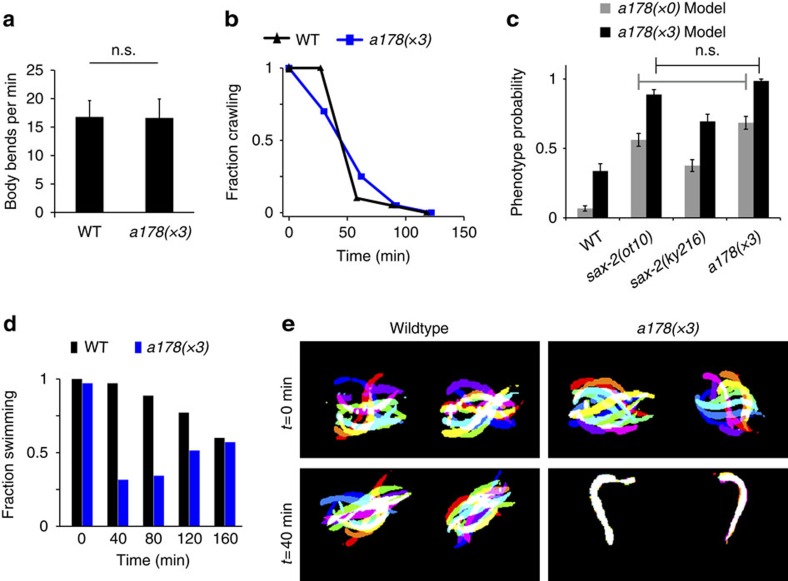
Subtle mutant a178 exhibits robust behavioural phenotypes.(a) Animals crawling on plate show no locomotive differences (ventral body bends per min), n=20 per genotype. Statistical comparison performed by t-test with a 95% confidence level. Error bars are standard deviation. (b) a178 exhibits normal acetylcholine release according to an aldicarb sensitivity assay. Plot represents fraction of animals moving after transfer to a 1 mM aldicarb NGM plate, n=20 per genotype. Aldicarb assays replicated five times with no differences between genotypes. (c) sax-2 alleles ot10 and ky216 phenocopy the a178 phenotype. Bar plots represent the average phenotype probability of each imaged population, according to the SWLR models built for a178(x0) and a178(x3). Error bars are s.e.m. Statistical comparison performed by t-test with a 95% confidence level and Bonferroni correction for multiple comparisons. Only nonsignificant differences displayed, all other comparisons have P<1e−6. (d) a178 animals display a drastic time-dependent reduction in swimming. Plot represents fraction of animals swimming after transfer to liquid from plate, n=35 per genotype. Replicate experiment with sax-2 alleles in Supplementary Fig. 8. (e) Swimming animals represented as an overlay of segmented images (10 frames, 750 ms, see Supplementary Videos 1–4), two individual worms per genotype and time point.